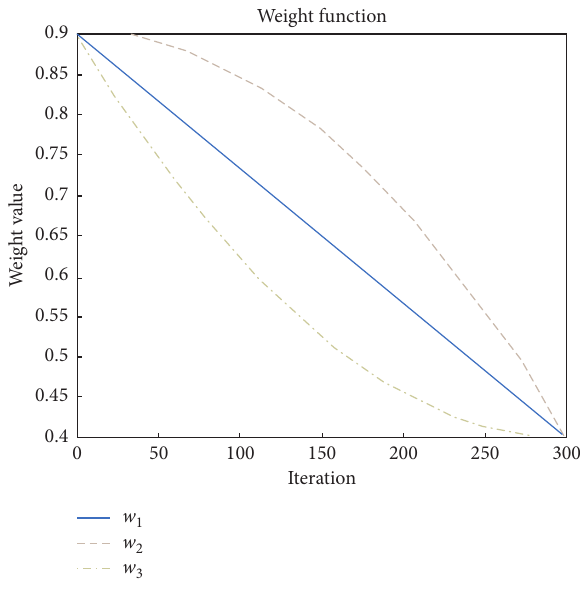
Figure 4: Weight function